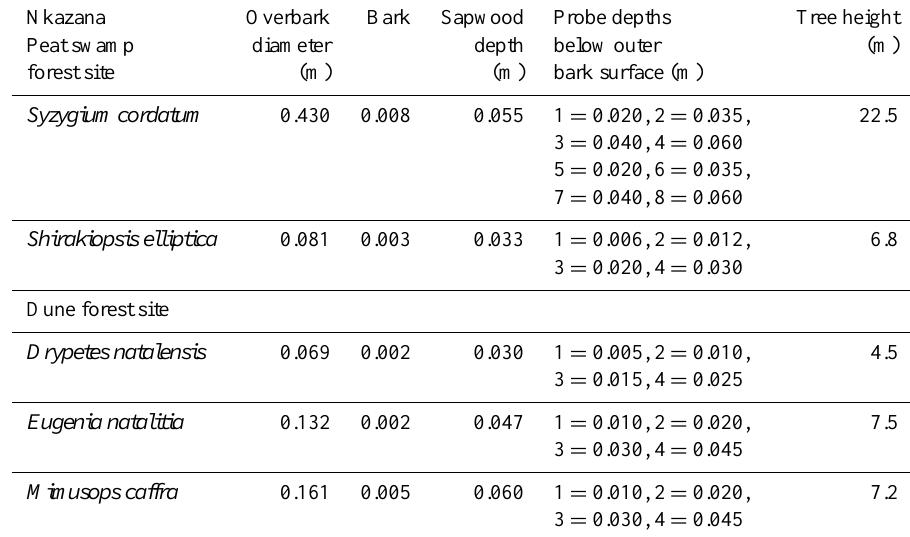
Table 1. Tree sizes and probe measurement depths. Nkazana Overbark Bark Sapwood Probe depths Tree height Peat swamp diameter depth below outer (m) forest site (m) (m) bark surface (m) Syzygium cordatum 0.430